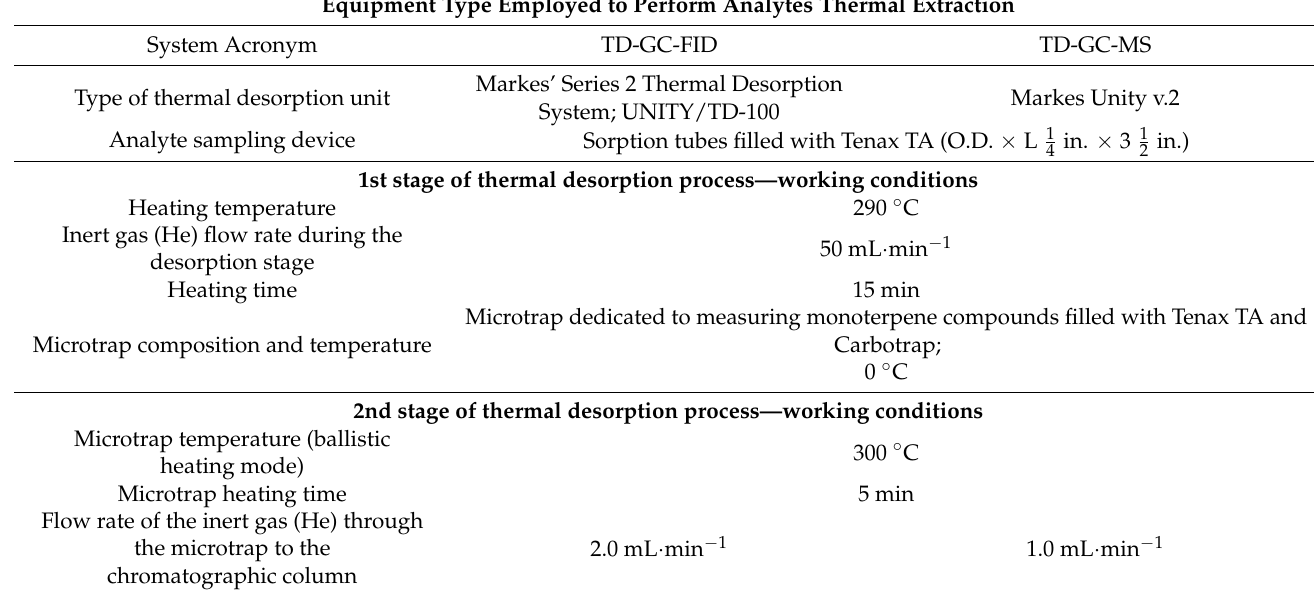
Table A1. Thermal desorption (TD) GC-FID and GC-MS system parameters used to assess the content level of selected representatives of organic compounds in atmospheric air in the investigated forest